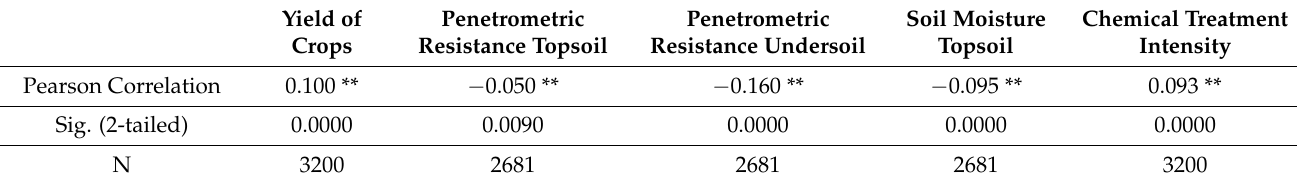
Table 1. Correlation coefficients for a number of CT on the land into 9 year.